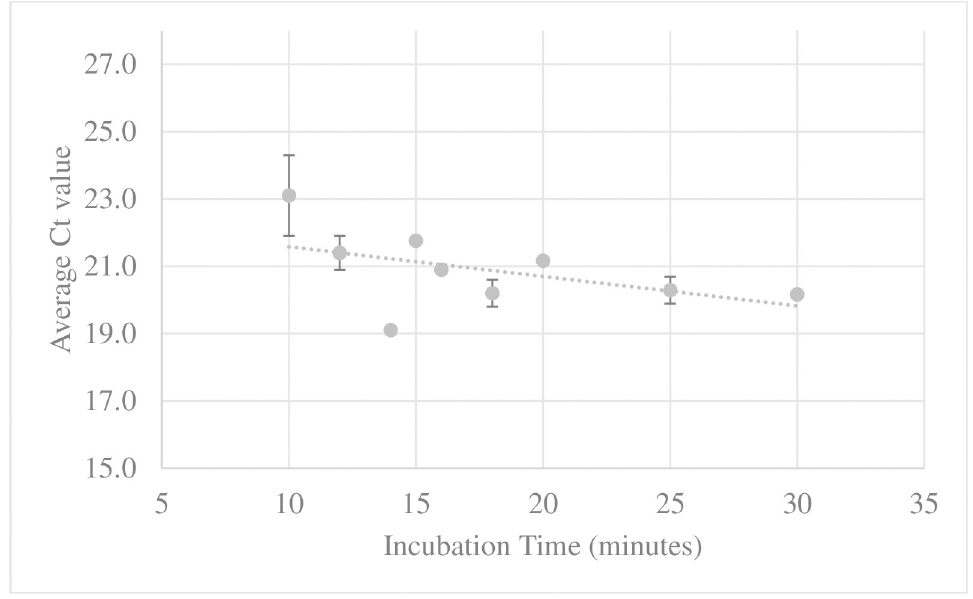
Fig 1. Effect of Buffer 1 incubation time on template yield measured by 18S rRNA real-time PCR (average Ct value; error bars represent the standard deviation between Ct values).